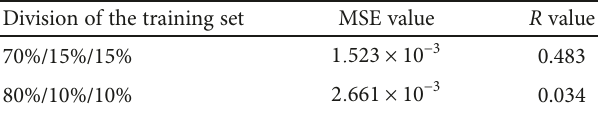
Table 4: Values of MSE and R depending on the division of the training set (for one neuron in the hidden layer and TRAINLM algorithm) in model ANN 1.